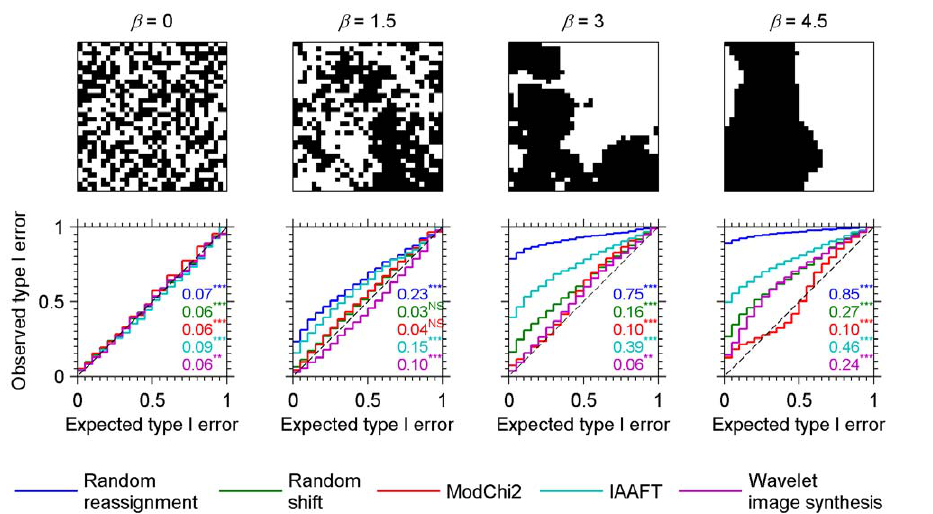
Figure 4. Type I error calibration curves for fractal binary data generated through Fourier synthesis and thresholding of 32 6 32 pixels images [ 27 ] . Observed versus expected type I error probabilities resulting from an independence tests on 1000 pairs of simulated images, are plotted for every combination of method (colour curves) and degree of spatial autocorrelation (panels) as measured by the energy spectrum exponent, b . Methods compared are random reassignments, random shifts, modified chi-square test of Cerioli (ModChi2), iterative amplitude adjusted Fourier transform (IAAFT), and wavelet-based image synthesis. Each bin is 0.05 wide. The Kolmogorov-Smirnov (K.-S.) maximum difference statistic which measures the departure from the line of identity (dashed line) is indicated for each curve along with results of the derived test of the departure: ***= p -value , 0.001; *=0.01 # p -value , 0.05; NS=not significant.